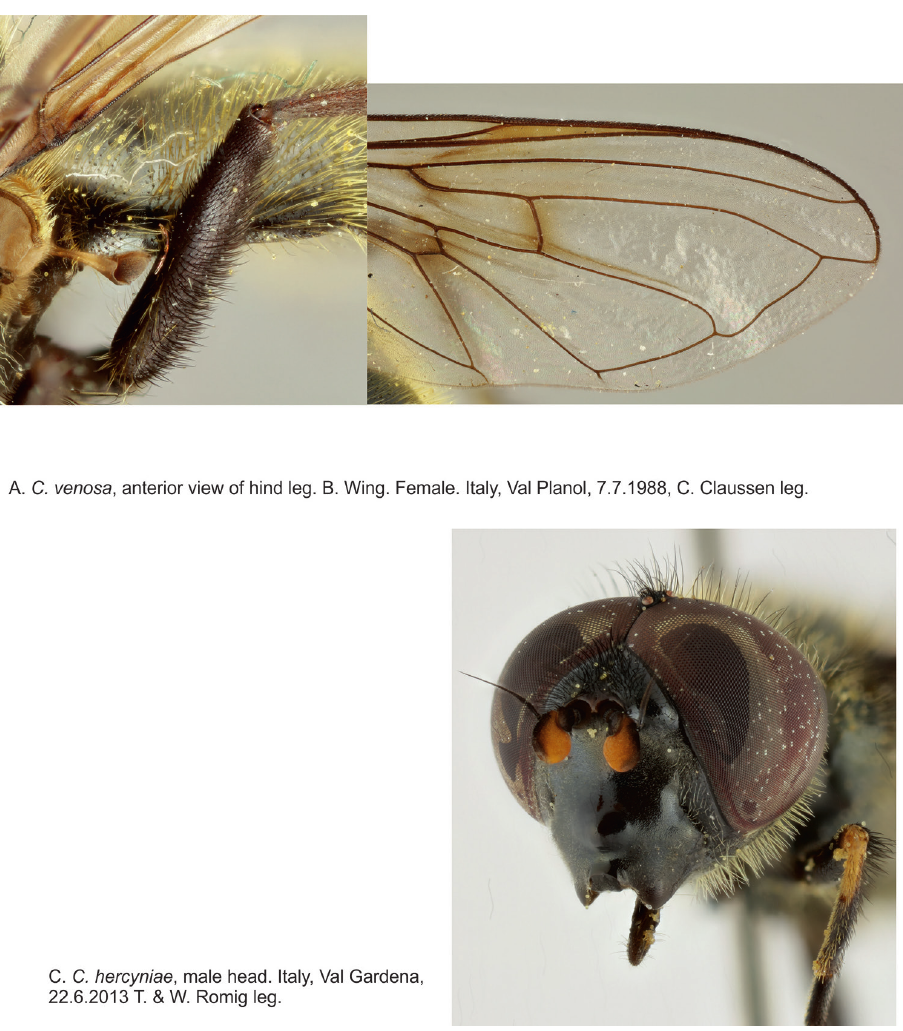
Figure 12. A, B Cheilosia venosa, metaleg and wing C C. hercyniae , male head.